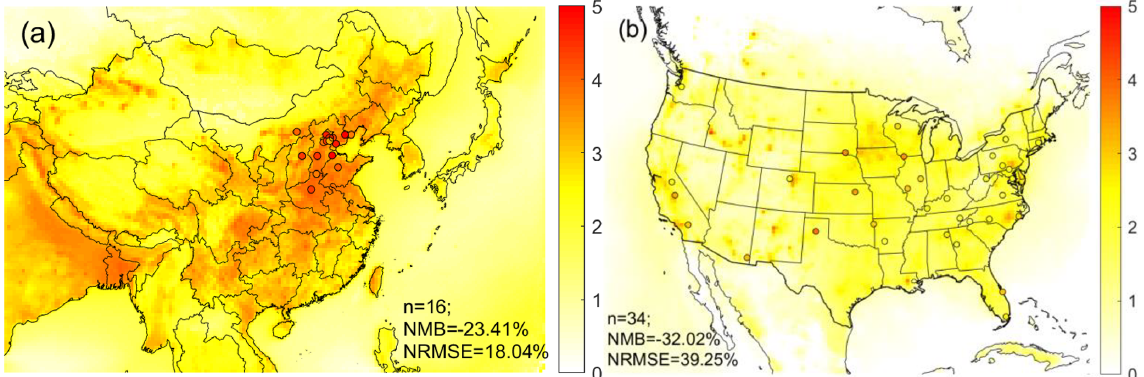
Figure 3. Overlay of annual mean pH calculated based on simulated concentrations (colored map) and observed concentrations (colored dots) over the study domain in (a) China and (b) the United States. Number of sites ( N ), normalized mean bias (NMB), and normalized root- mean-square error (NRMSE) are provided in each figure. The world shapefiles were obtained from Esri (ArcGIS Hub, Countries WGS84, http://www.arcgis.com/home/item.html?id=30e5fe3149c34df1ba922e6f5bbf808f, last access: 21 June